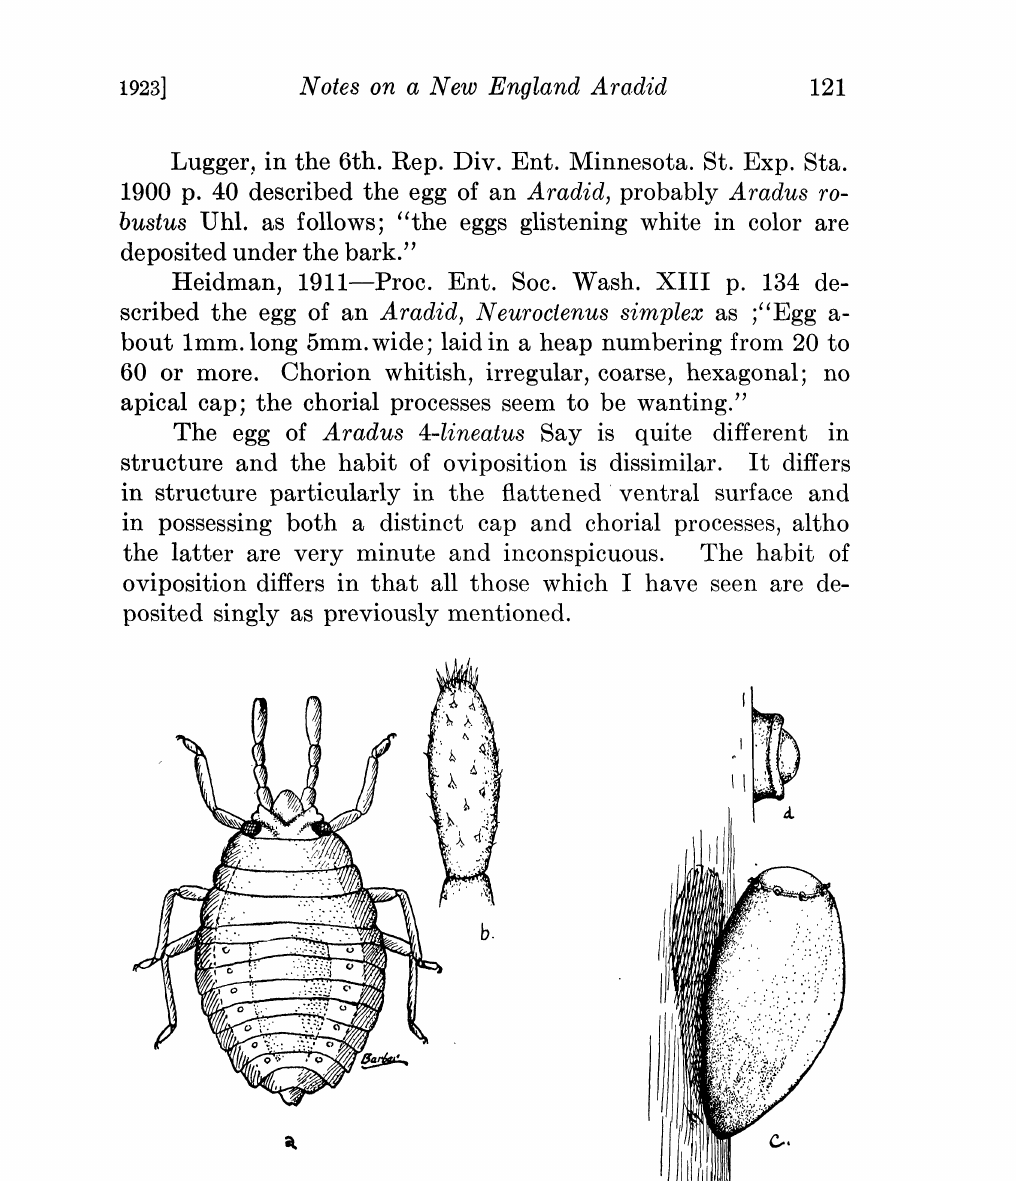
Fig. 2. Aradus 4 lineatus Say. a, first instar nymph; b, apical joint of antennae of first instar nymph; c, egg, viewed laterally; d, corial process of